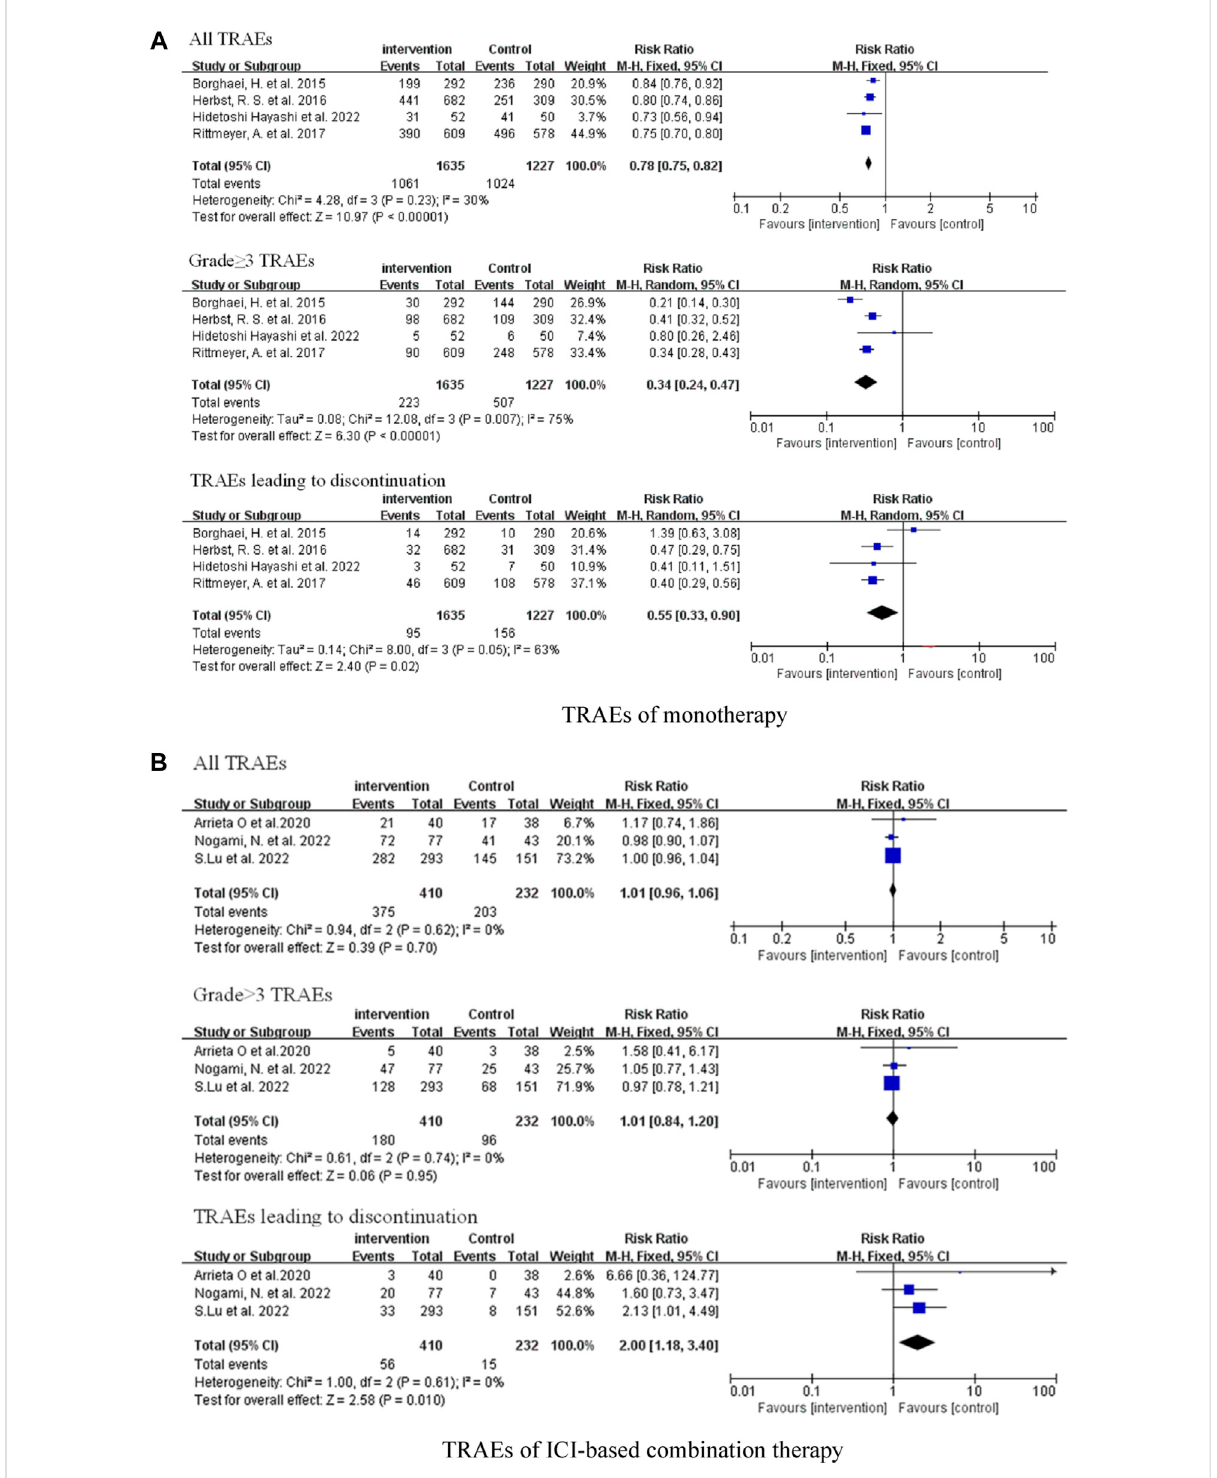
FIGURE 5 Forest Plot of Overall Comparison of TRAEs. (A) TRAEs of monotherapy. (B) TRAEs of ICI-based combination